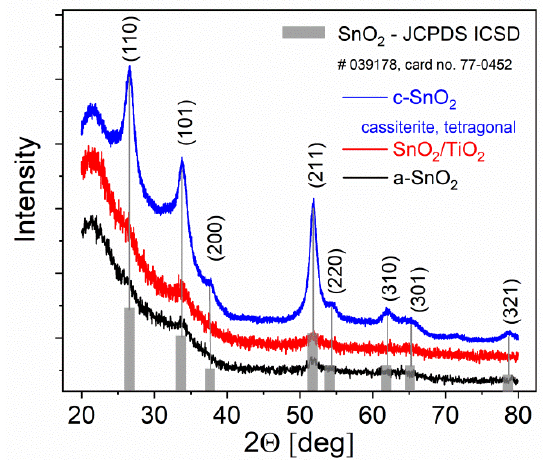
Figure 5. X-ray of di ff raction, XRD, patterns of cassiterite, tetragonal SnO 2 phase, c-SnO 2 , amorphous a-SnO 2 and SnO 2 / TiO 2 heterostructured thin films.